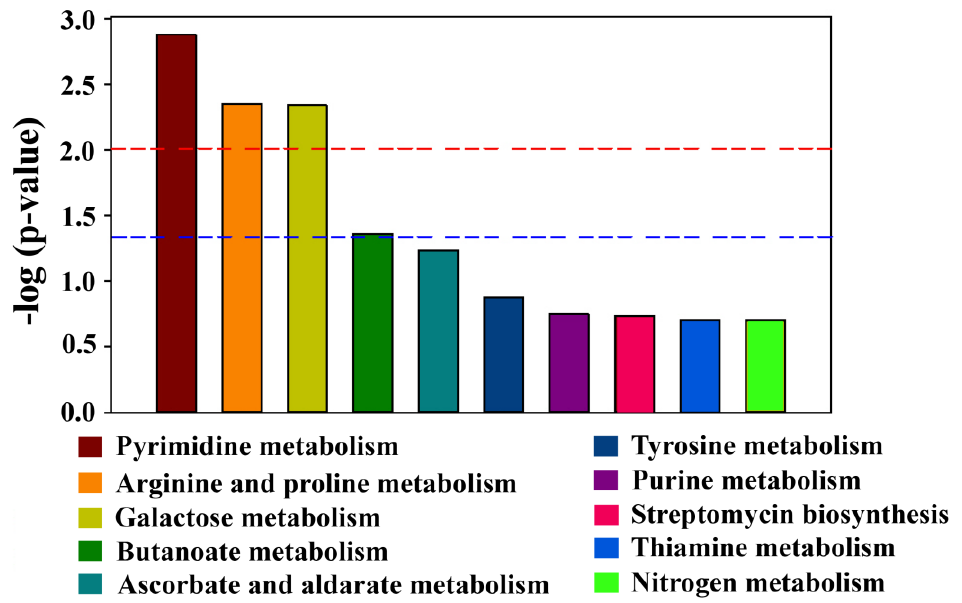
Figure 7. Metabolic pathway enrichment map of different metabolites in bayberry rhizosphere soil. D and P represent trees affected by decline diseased and disease in combination with the fungicide prochloraz, respectively. When the top of the bar is higher than the blue ( p < 0.05) or red line ( p < 0.01), the signal pathway is significant.